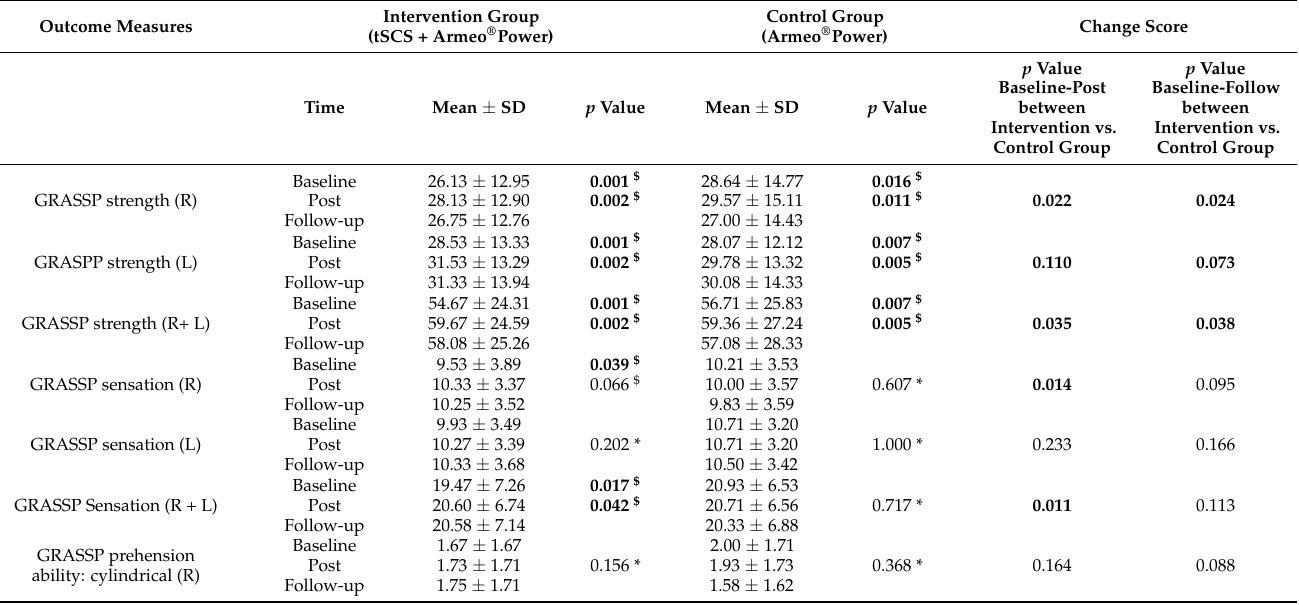
Table 3. Data and statistics of all the measures for intervention and control